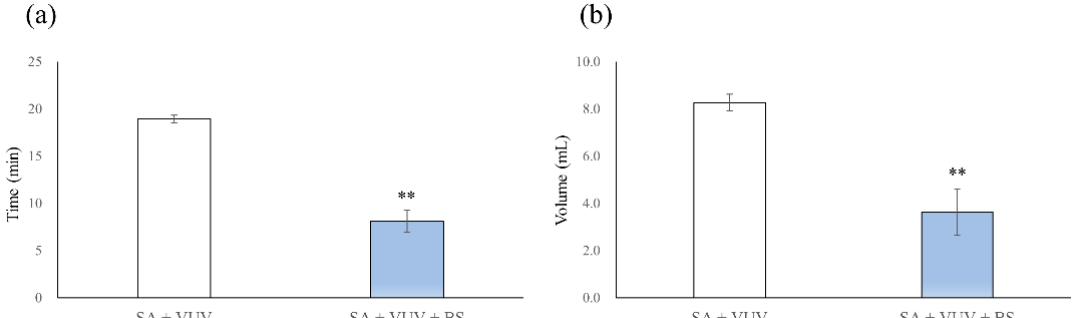
Figure 5. In vitro test of dynamic blood clotting: ( a ) time (min) until complete hemostasis; ( b ) volume (mL) of the blood collected in the underlying tube. SA + VUV, an SA surface with vacuum-UV treatment; SA + VUV + BS, an SA surface coated with a pH-buffering agent after vacuum-UV treatment. Mean ± SD, ** p < 0.01 by Kruskal–Wallis test.